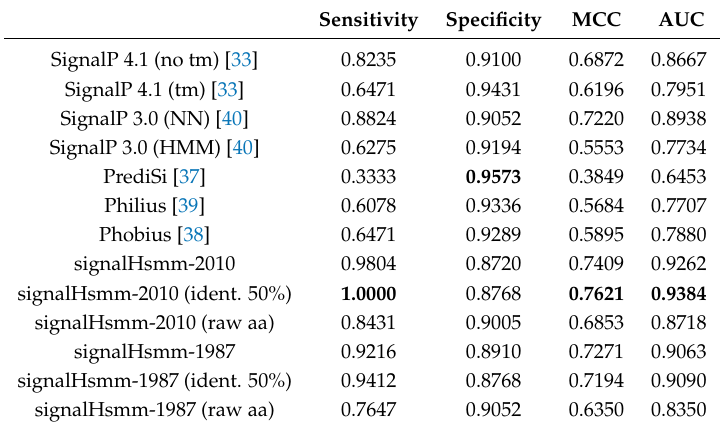
Table 4. Comparison of Sensitivity, Specificity, Matthews Correlation Coefficient (MCC) and Area Under the Curve (AUC) for different classifiers and signal peptide-bearing proteins from members of Plasmodiidae . The abbreviations ’tm’ and ’no tm’ indicate version considering and not considering transmembrane domains, whereas ’ident. 50%’ means removal from the learning set sequences with the sequence identity larger than